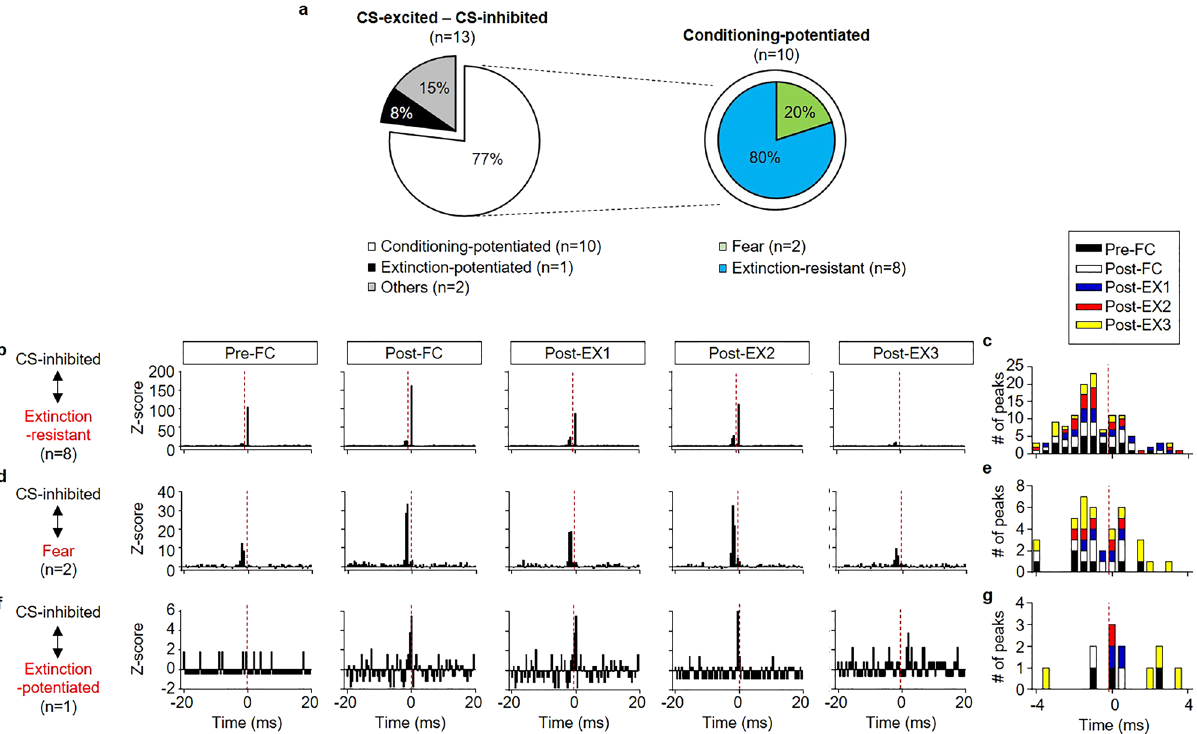
Figure 8. Functional connectivity between CS-excited neurons and CS-inhibited neurons in the BA L . ( a ) Types of functional connectivity between CS-excited neurons and CS-inhibited neurons (left), between conditioning-potentiated neurons and CS-inhibited neurons (right). ( b, d, f ) Z-score cross-correlograms between CS-inhibited neurons and extinction-resistant neurons ( b ; n = 8, 61% of CS-excited and CS-inhibited neuronal pairs, extinction-resistant neurons as references and CS-inhibited neurons as targets), between CS-inhibited neurons and fear neurons ( d ; n = 2, 16%, fear neurons as references), and between a CS-inhibited and an extinction-potentiated neuron ( f ; n = 1, 8%, extinction-potentiated neuron as a reference). ( c, e, g ) The distribution of the time of significant peaks in cross-correlograms for the pairs between CS-inhibited neurons and ( c ) extinction-resistant neurons, ( e ) fear neurons, and ( g ) extinction-potentiated neurons. CS-inhibited neurons tend to fire before than extinction-resistant neurons and fear neurons in the